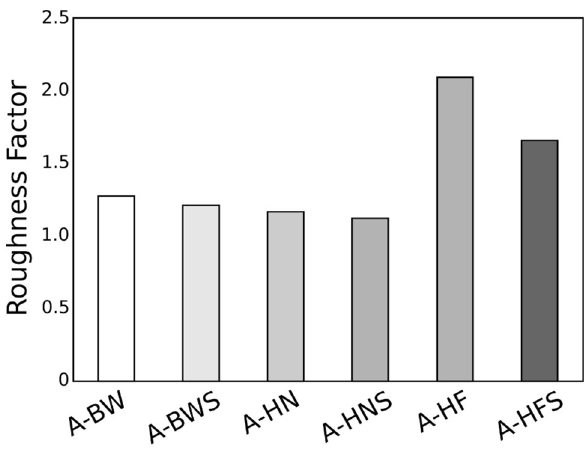
Figure 4. Roughness Factor for all surface treated samples.